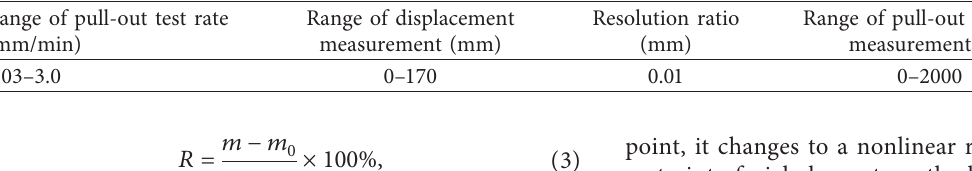
Figure 2: Pull-out test Table 1: Main technical indexes of pull-out test equipment.